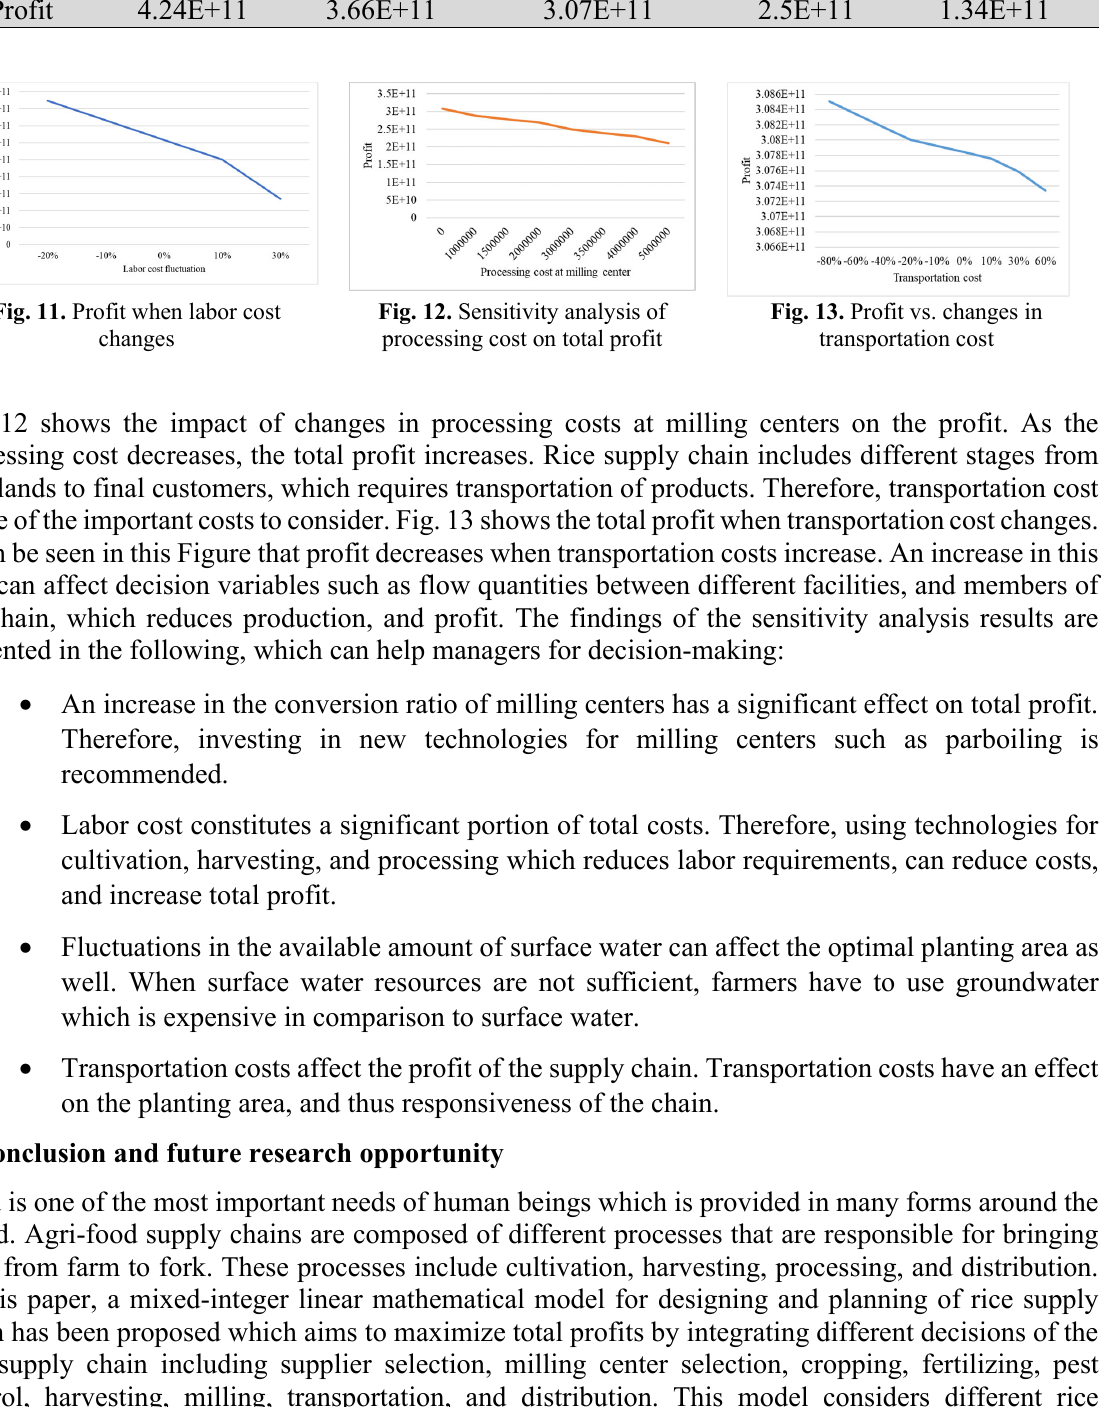
Fig. 13. Profit vs. changes in transportation